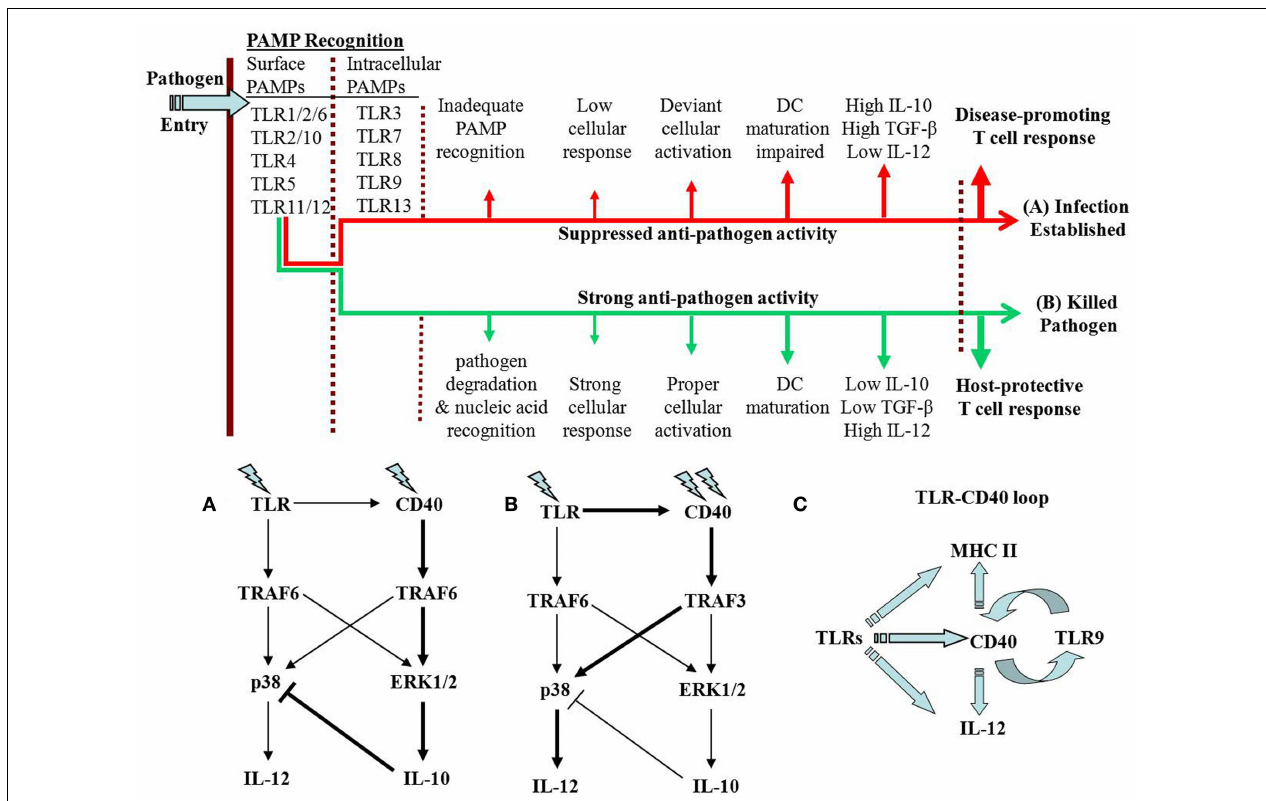
intracellularTLRs are optimally activated. In L. major infection, the host-protective function of CD40 involves strong p38-MAPK activation with resultant IL-12-dependentTh1 response.The thicker arrows in (A,B) represent the dominant signaling. (C) Possible feedback loops are proposed.TLRs increase CD40 expression but CD40 enhances the expression of onlyTLR9, an intracellularTLR that recognizes CpG motifs in pathogen DNA.This can be viewed as a positive feedback loop for enhancing IL-12 production andTh1 response.The other arm of the loop is theTLR-activated MHC-II expression, which is linked to CD40 expression and DC maturation.This is also required for a stronger and prolonged immune response against a